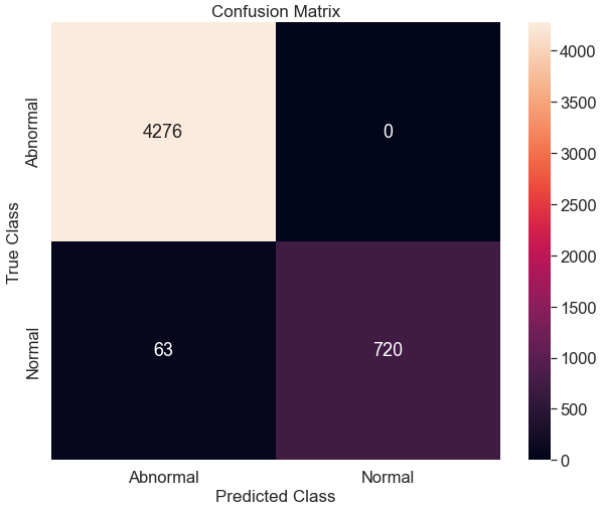
Figure 13. The confusion matrix for the anomaly detection proposed model between the normal and abnormal